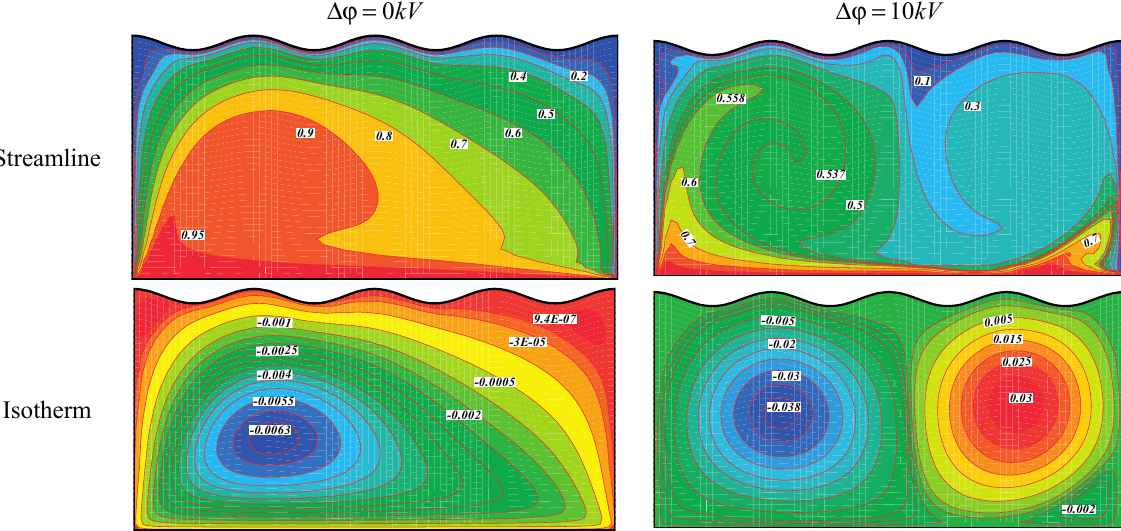
Figure 5. Effect of supplied voltage on streamlines and isotherm when